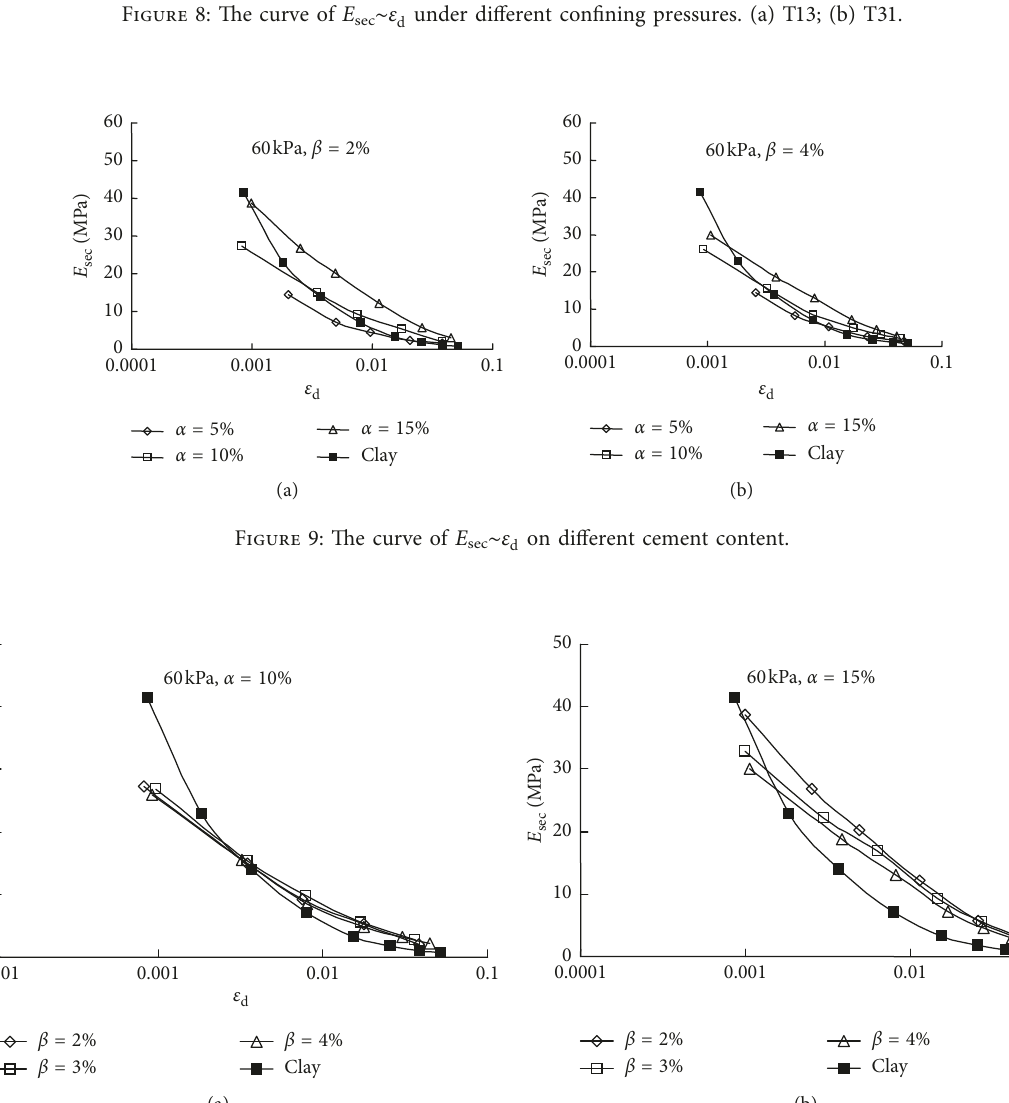
Figure 8: The curve of E